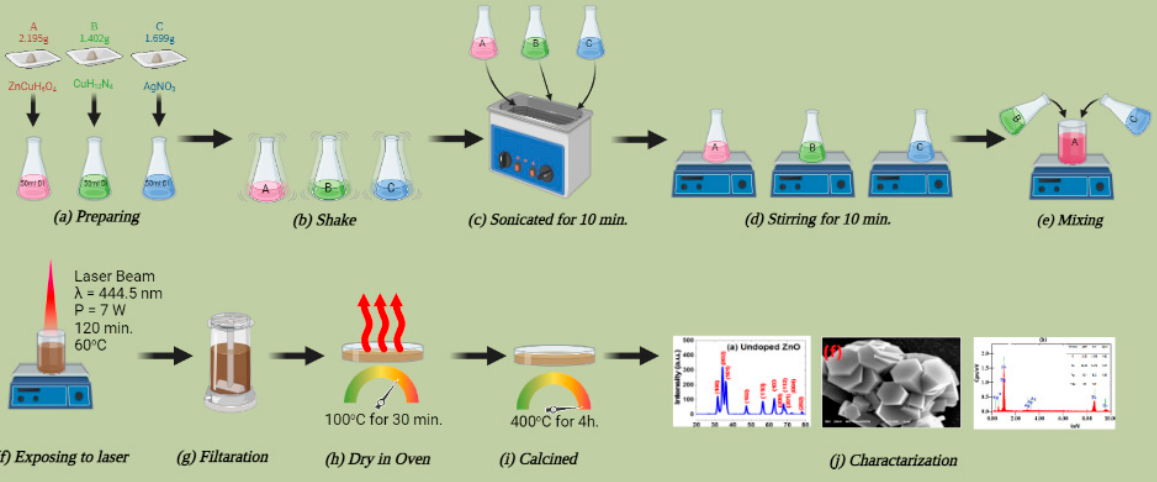
Figure 2. Schematic diagram and illustration of the working principle for synthesizing pure and Ag- doped ZnO submicron